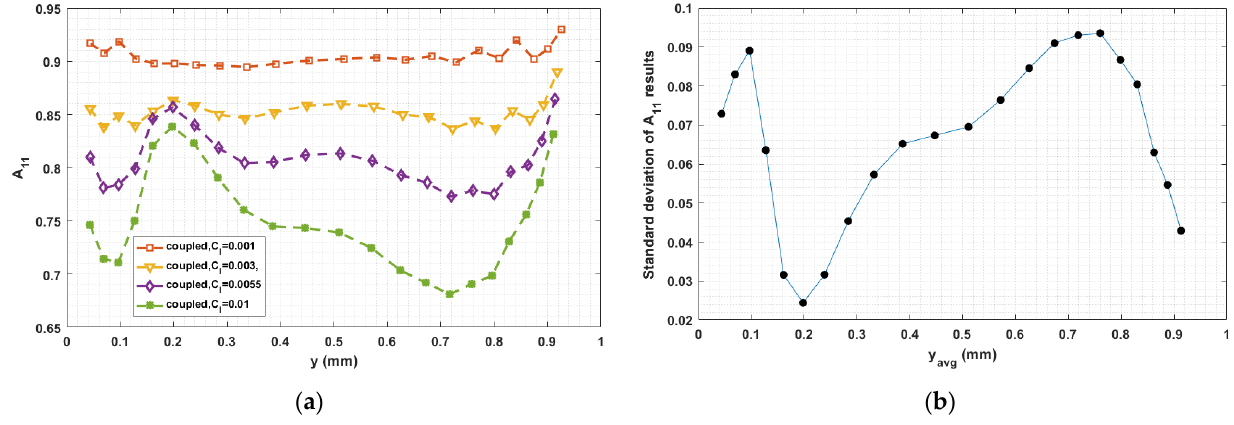
Figure 21. ( a ) Fiber orientation tensor component (cid:1827) (cid:2870)(cid:2870) at nozzle exit; ( b ) standard deviation of the parametric study resulted (cid:1827) (cid:2869)(cid:2869) versus the averaged x locations.